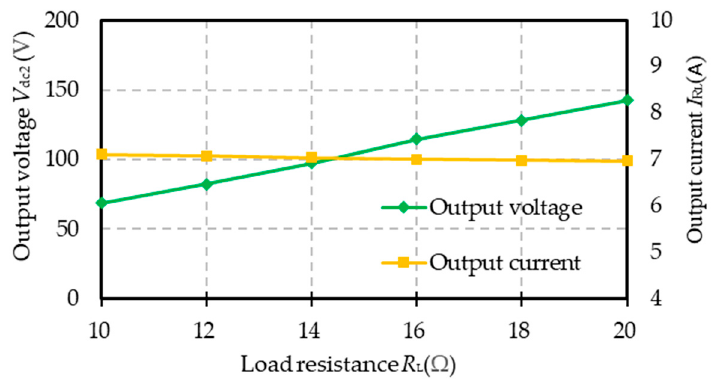
Figure 11. Output voltage/current variation with load resistance.